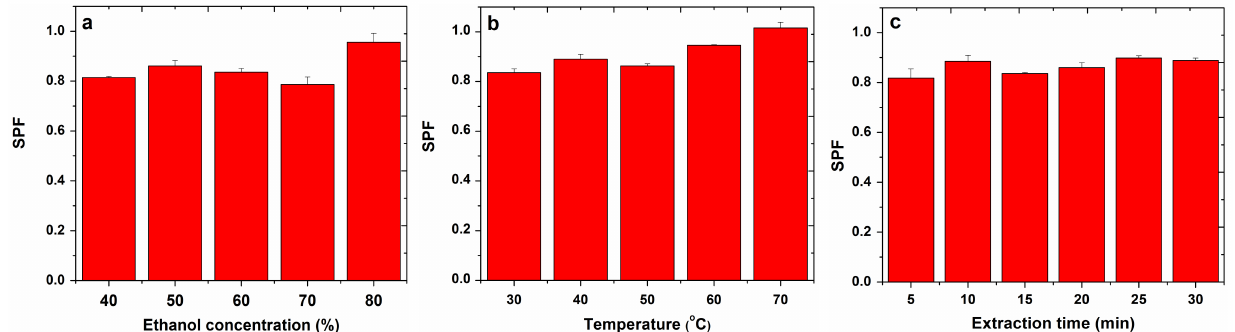
Figure 6. Influence of ethanol concentration ( a ), temperature ( b ) and extraction time ( c ) on SPF determined for apple extracts, obtained by